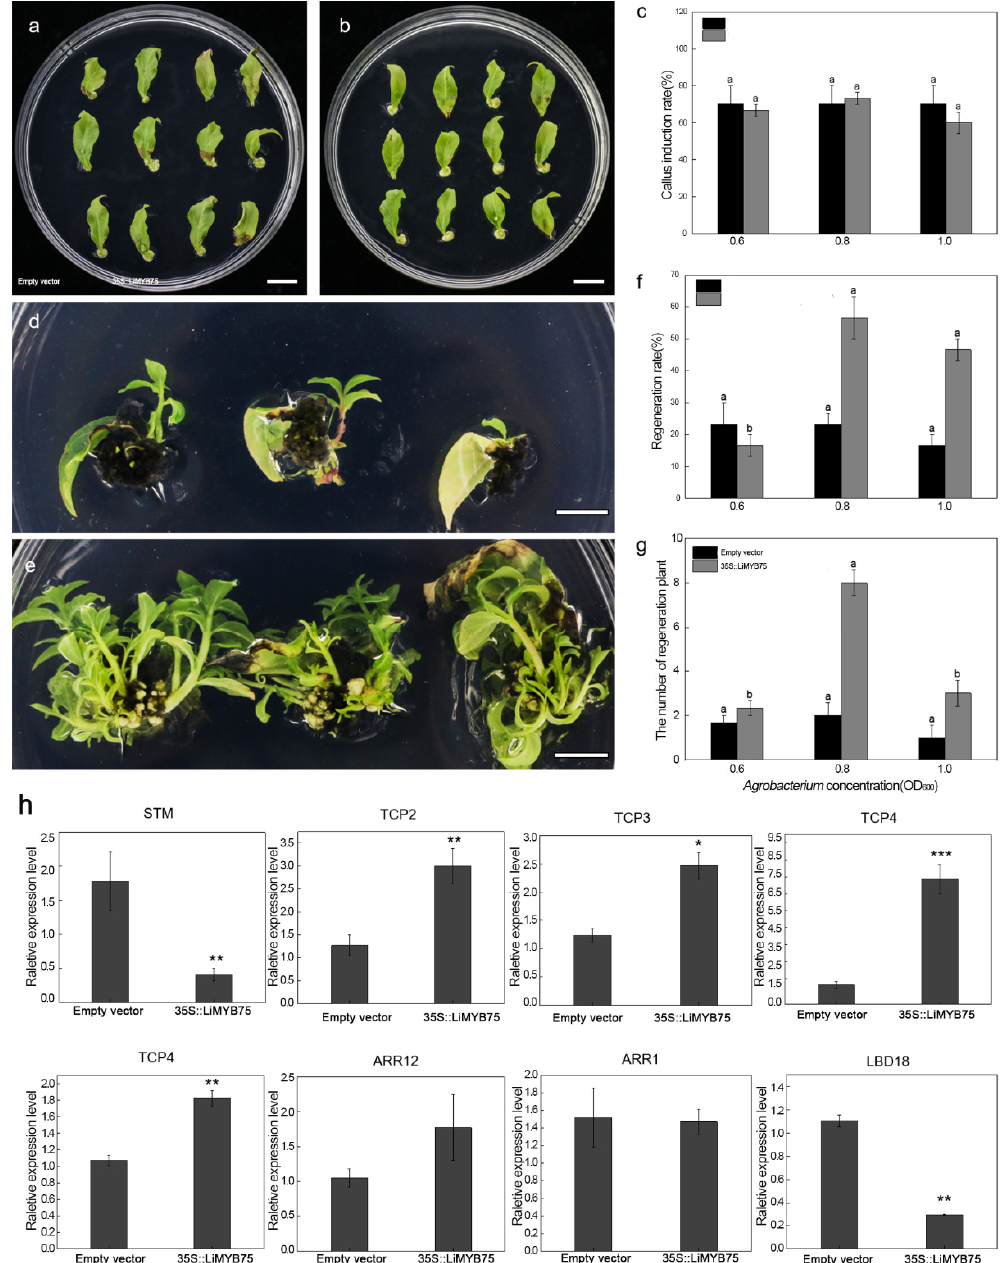
Figure 6. LiMYB75 overexpression enhances the effectiveness of calli regeneration in Lagerstroemia indica . ( a , d ) Whole-leaf explants were infiltrated with the empty vector pBI121-GFP at OD 600 = 0.8. Scale bars = 1 cm. ( b , e ) Whole-leaf explants were infiltrated with the vector 35S::LiMYB75 at OD 600 = 0.8. Scale bars = 1 cm. Infected whole-leaf explants were cultured on CIM3 for 14 d ( a , b ) and then transferred to CRM1 for 30 d ( d , e ). The statistical results of callus induction rate ( c ), regeneration rate ( f ), and the number of regeneration plants after Agrobacterium infection (OD600 = 0.6, 0.8, 1.0) ( g ). ( h ) Expression analysis of eight genes involved in callus formation. Total RNA was extracted from whole-leaf explants infiltrated with the empty vector pBI121-GFP and the vector 2 × 35S::LiMYB75-eGFP at OD 600 = 0.8 after 48 h, respectively. The error bars represent the standard deviation of expression from three independent biological replicates. The 2 −Δ Ct method was used to evaluate the quantitative variation between replicates. Student t -test: * p < 0.05, ** p < 0.01, p *** < 0.001 . Different lowercase letters indicate significant differences at p < 0.05.